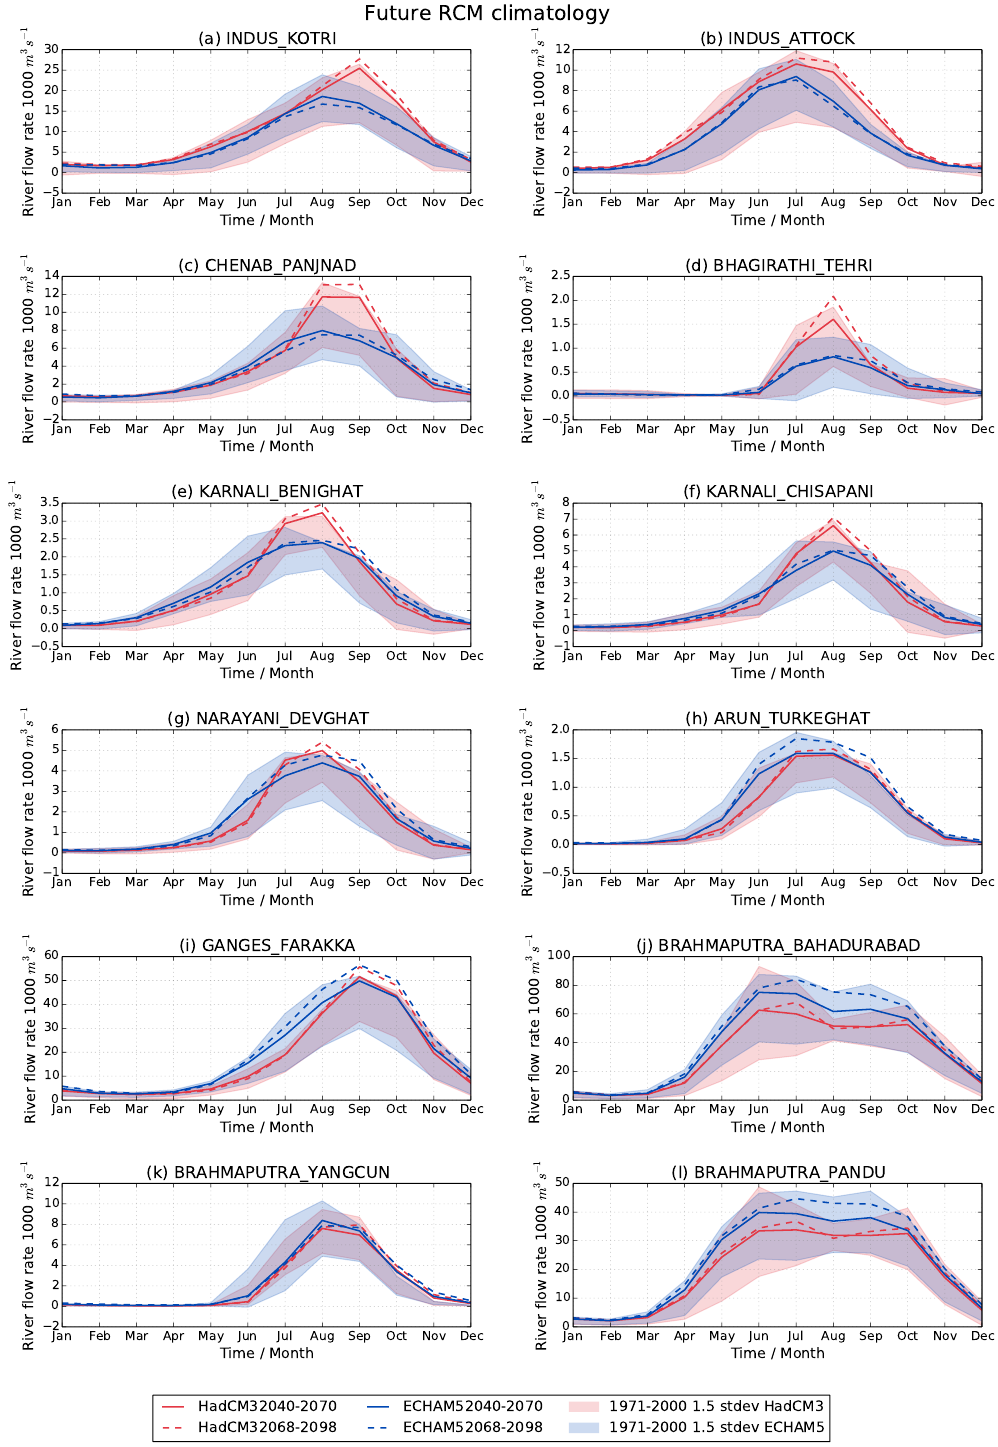
Figure 10. Seasonal cycle of river flow in each of the RCMs (HadCM3 – red, ECHAM5 – blue) for the two future periods: 2050s (solid lines) and 2080s (dashed lines), with shaded regions showing 1.5SD from the mean for 1971–2000 for each river gauge.